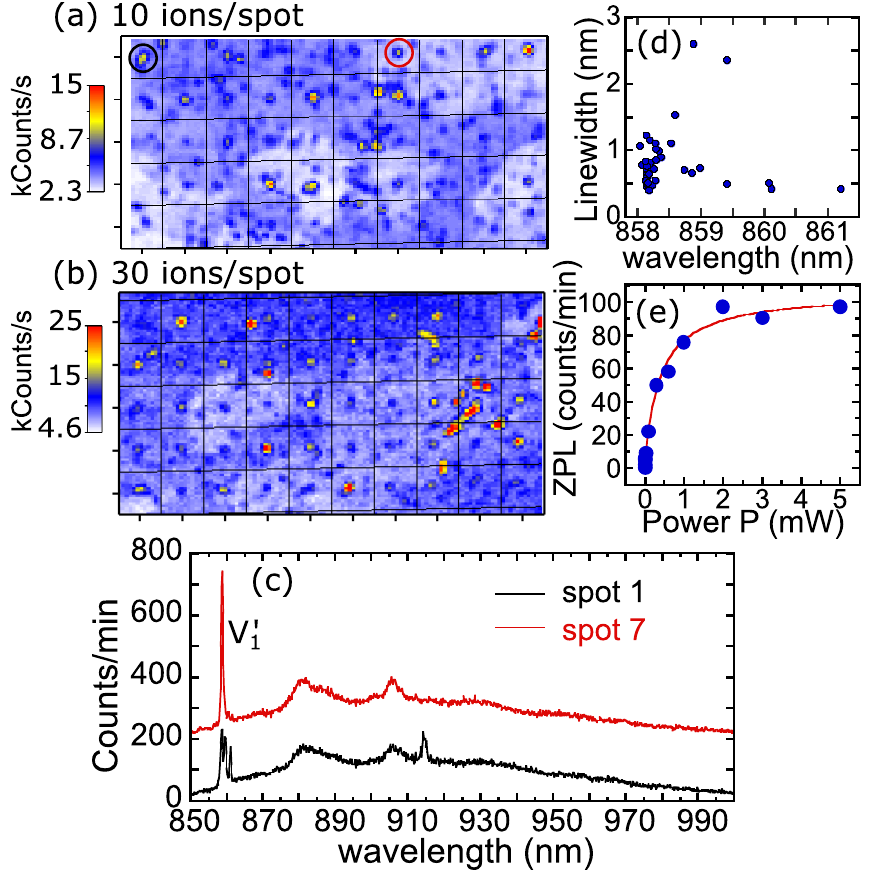
Figure 2. ( a , b ) LT confocal fluorescence maps integrating over the entire spectrum at the two lowest implantation doses: ( a ) 10 ions/spot and ( b ) 30 ions/spot. A grid is superimposed on the image as a guide to the eye. The expected implantation site is at the center of each grid square. ( c ) LT PL spectra from two spots of the 10 ions/spot array, with the spot 7 spectrum offset by 200 counts/min. Spots 1 and 7 are identified in ( a ) with black and red circles, respectively. ( d ) V 1 ′ ZPL linewidth at 4.8 K versus center emission wavelength for the 10 ions/spot array. ( e ) V 1 ′ ZPL saturation curve at